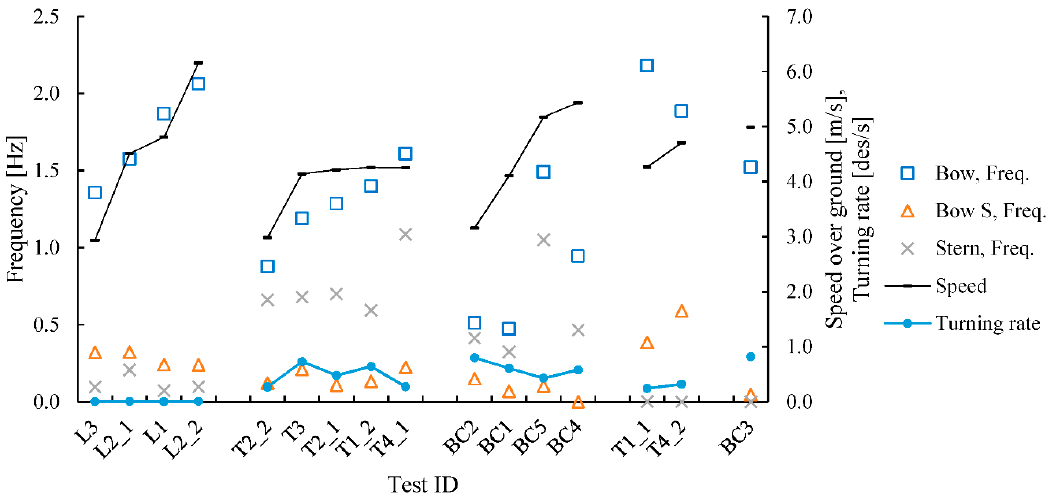
Figure 10. The frequency of measured peak loads, obtained speed, and turning rate in different tests. In the legend, Bow S, Stern, and Freq. refer to Bow Shoulder, Stern Shoulder, and Frequency, respectively. Table 8. The frequency of measured peak loads in Hertz in different tests.